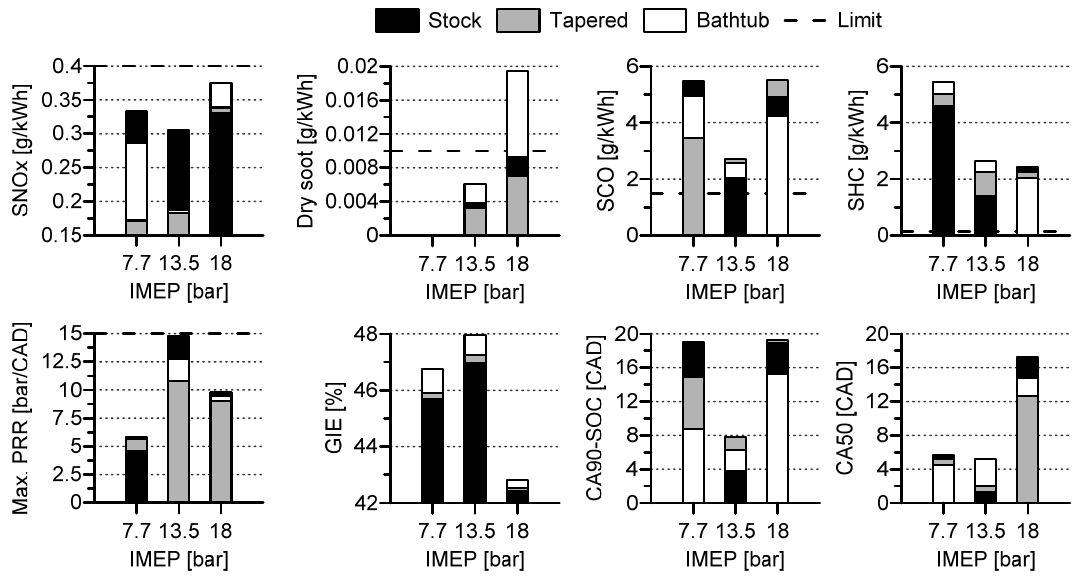
Figure 7. Best merit function results for each piston geometry at the different engine loads at 1200 rpm. Note that all bars have the same baseline value.